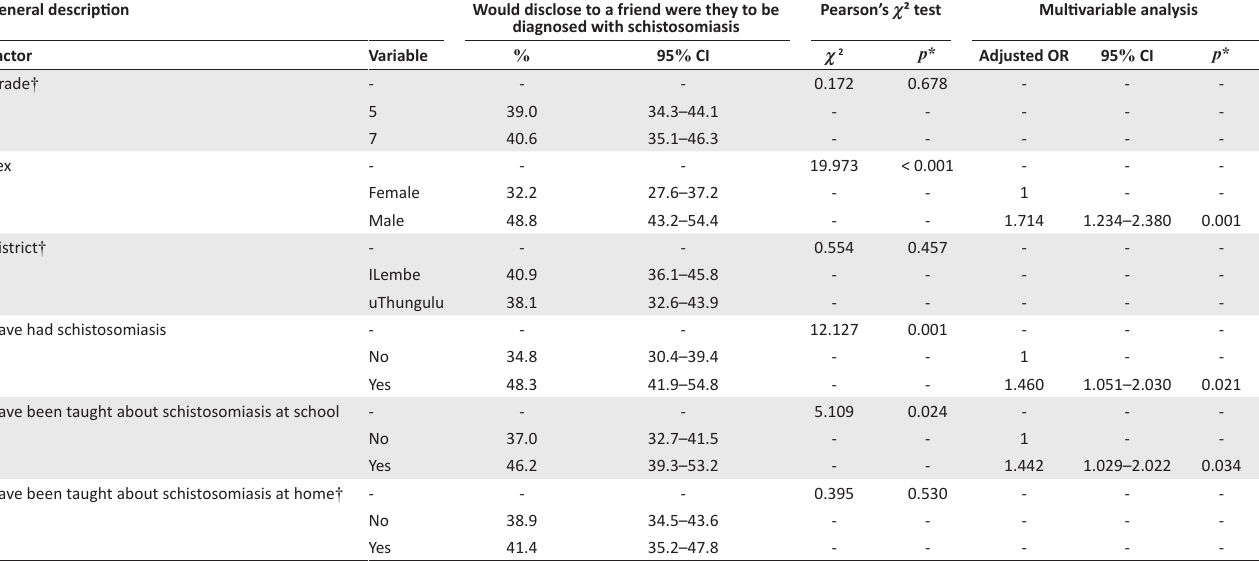
TABLE 3: Pearson’s χ 2 test and multivariable logistic regression analyses of factors affecting whether a learner would disclose to their friend were they to have schistosomiasis. General